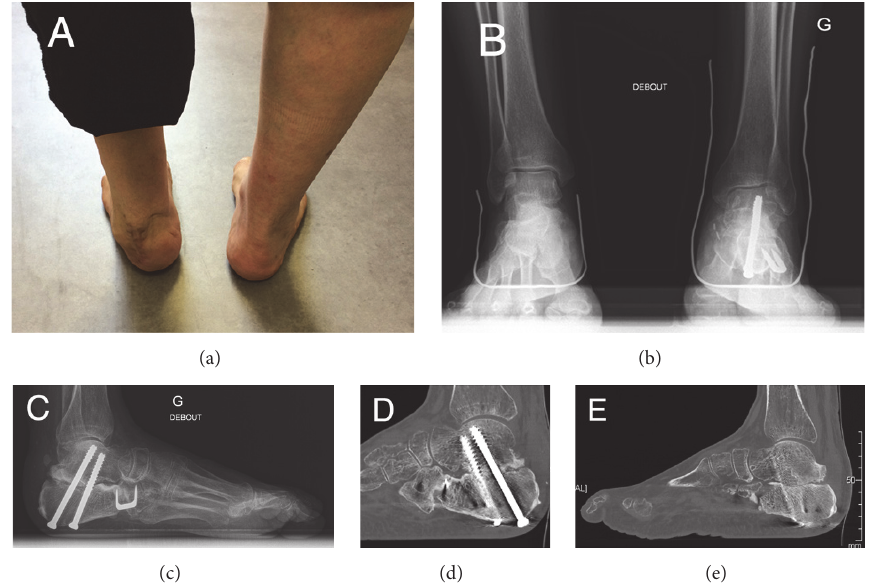
Figure 4: Latest follow-up assessment: Photograph shows a slight varus of the hindfoot (a). X-ray (b) and scan (c) assessment at 12-month follow-up with Meary incidence showing the residual varus of the